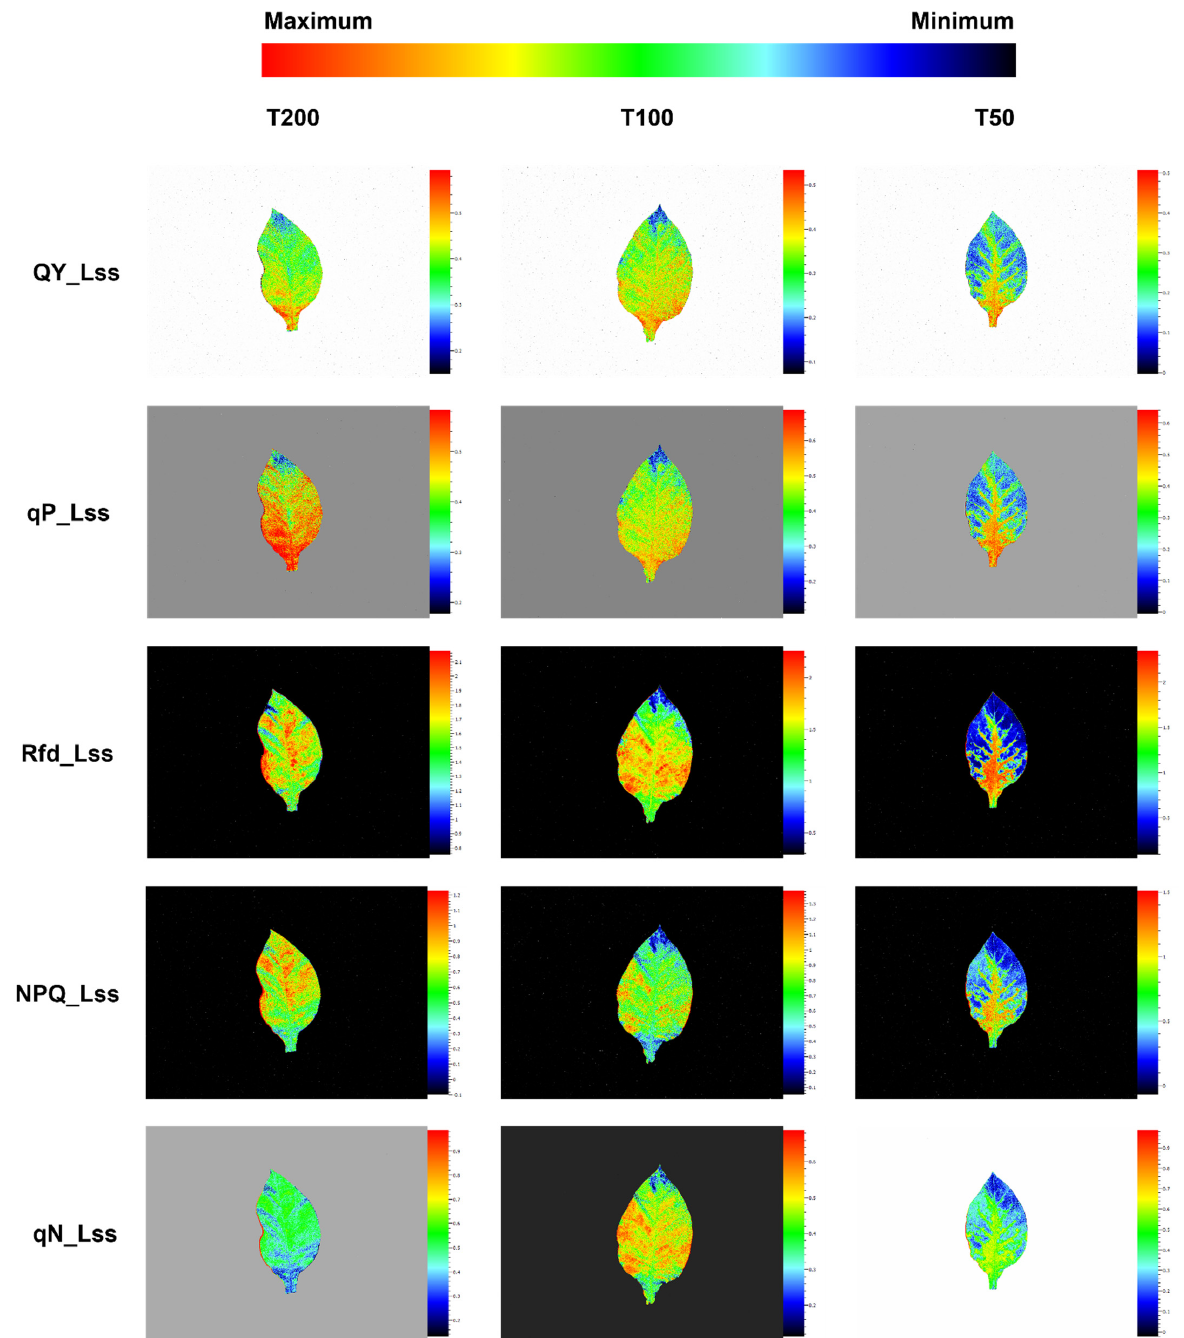
Figure 5. Representative chlorophyll fluorescence images show spatial heterogeneity. QY_Lss (PSII quantum yield), qP_Lss (open reaction centers), Rfd_Lss (fluorescence decline ratio), NPQ_Lss (non-photochemical quenching), and qN_Lss (non-photochemical quenching coefficient) of cigar tobacco seedlings under different light intensities. T200 represents the light intensity of 200 μ mol m − 2 s − 1 ; T100 represents the light intensity of 100 μ mol m − 2 s − 1 ; and T50 represents the light intensity of 50 μ mol m − 2 s − 1 .